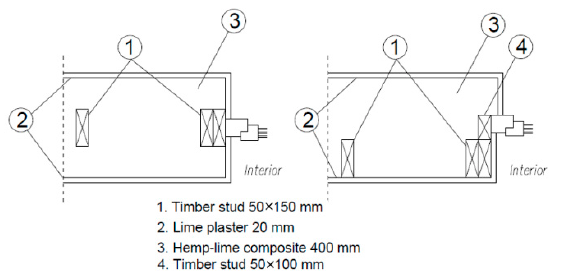
Figure 8. Window placement in the wall in the cases: with the timber frame located centrally in relation to the wall thickness (on the left ) and located on the inner side of the wall (on the right ).